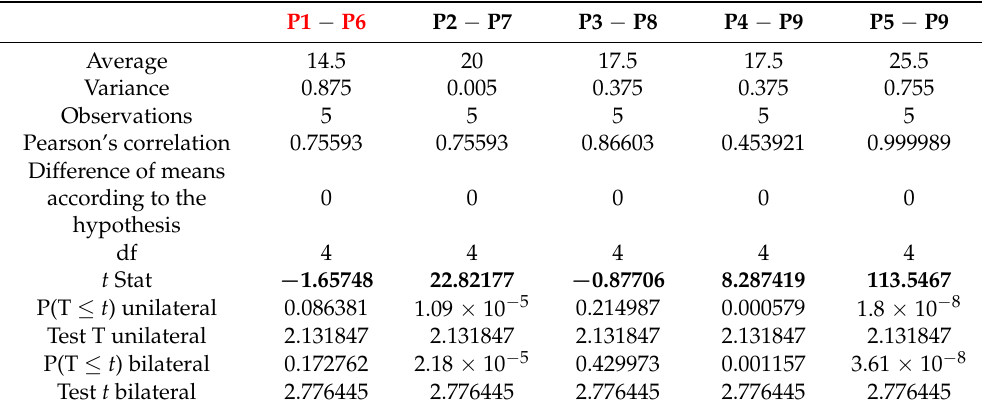
Table 6. Among ‐ subject comparison (comparison of samples with the same amounts of Hblock) t ‐ test: pairwise pairing with two samples for the mean.